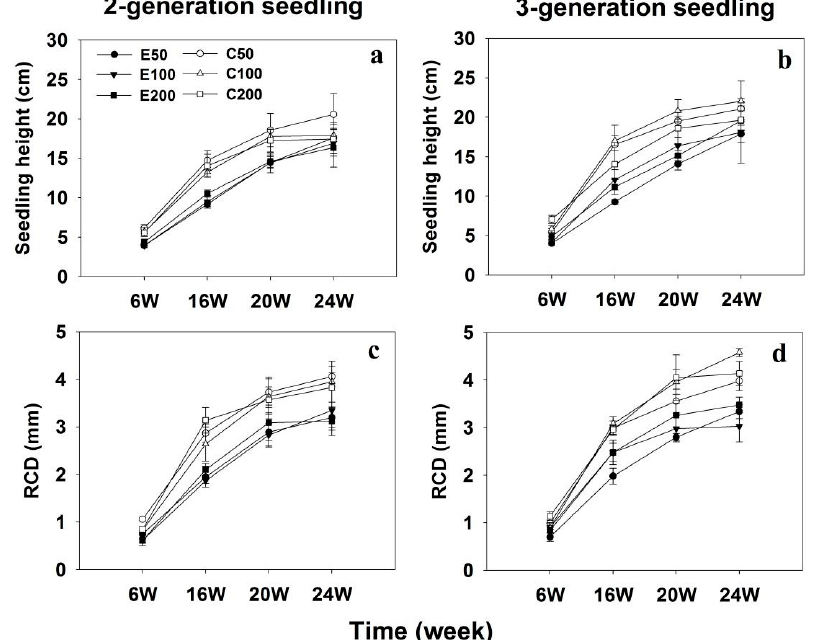
Figure 1. The height ( a , b ) and root collar diameter ( c , d ) in 2-generation and 3-generation Chinese fir seedlings under conventional and exponential fertilization regimes at three fertilization levels. RCD, root collar diameter; C50, C100, and C200 indicate conventional fertilization delivering a seasonal total of 50, 100, and 200 mg P per seedling at a constant rate; E50, E100, and 200 indicate exponential fertilization adding a seasonal total of 50, 100, and 200 mg P per seedling.